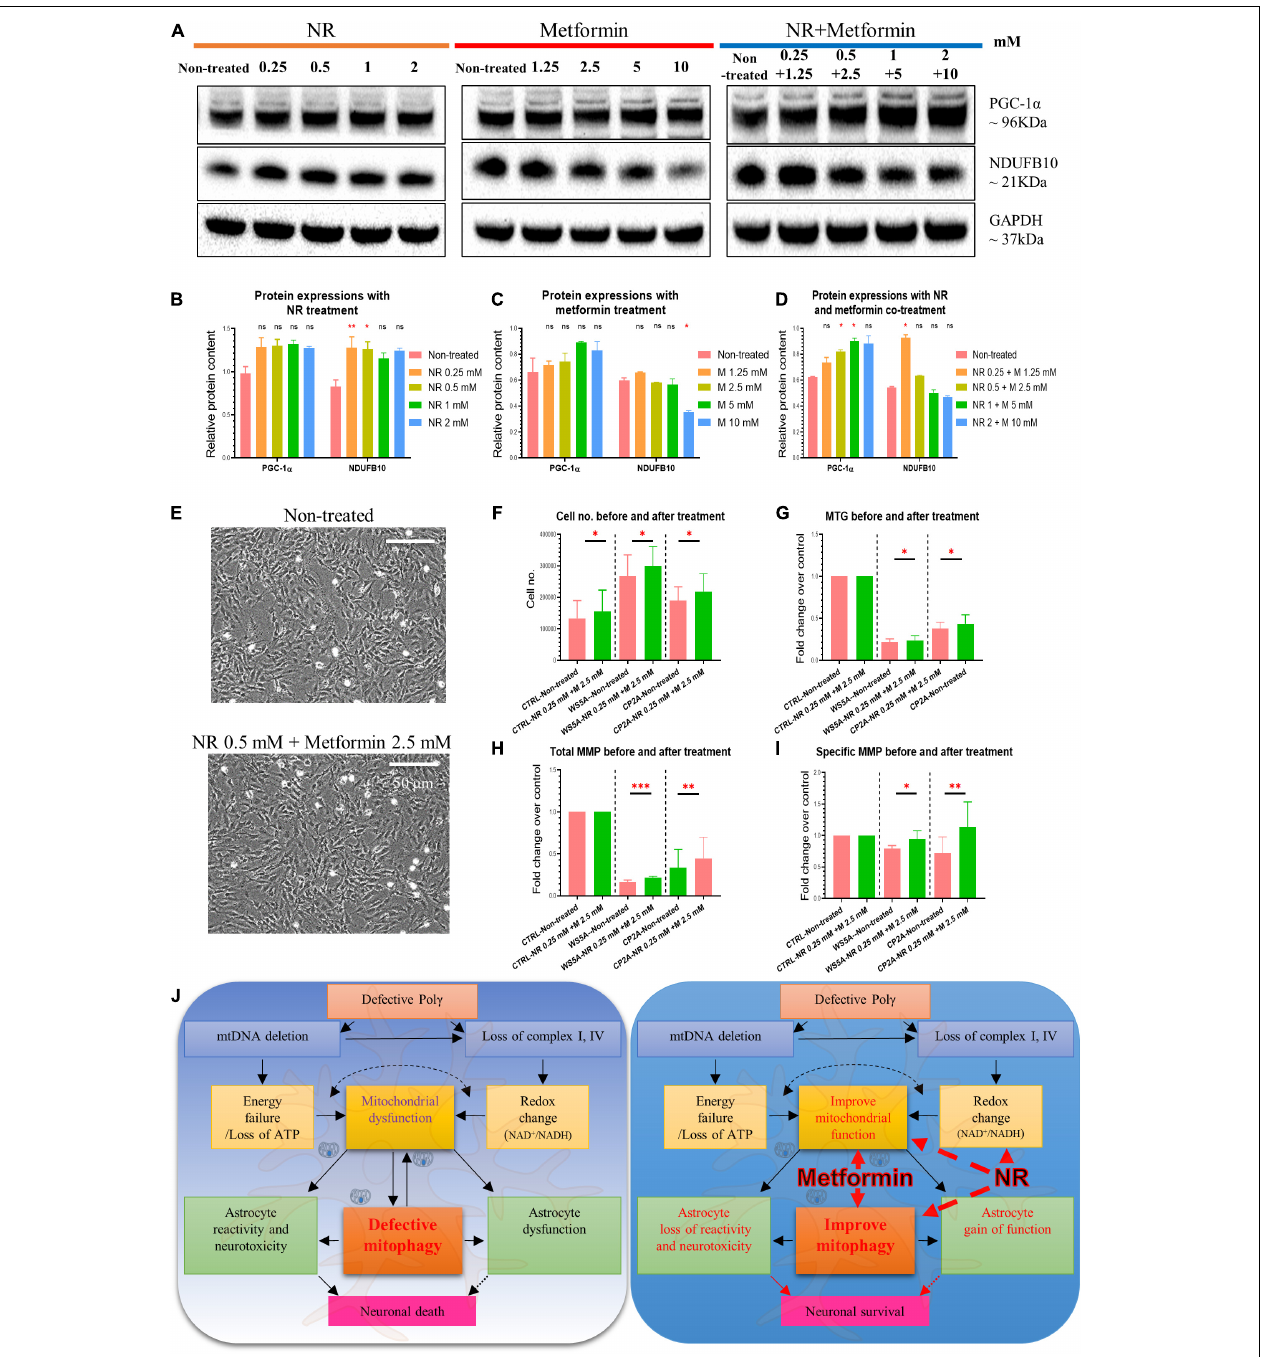
FIGURE 8 | Nicotinamide riboside and metformin treatment improve mitochondrial function in POLG-mutant astrocytes. (A) Representative images of the western blotting for NDUFB10, PGC-1 α , and GAPDH in the POLG WS5A astrocytes treated with a serial concentration of NR alone, metformin alone, and co-treatment for 72 h. (B–D) Protein quantifications of the western blotting in A for NDUFB10 and PGC-1 α in the POLG WS5A astrocytes treated with a serial concentration of NR alone (B) , metformin alone (C) , and co-treatment (D) for 72 h. (E) Representative phase-contrast images of WS5A astrocytes before and after the dual treatment of NR 0.5 mM and metformin 2.5 mM. Scale bar is 50 µ m. (F) Cell number counting of WS5A astrocytes before and after the dual treatment of NR 0.5 mM and metformin 2.5 mM. (G–I) Flow cytometric analysis for MTG (G) and MMP at total level measured by TMRE (H) and specific MMP level calculated by total TMRE/MTG (I) of WS5A astrocytes before and after the dual treatment of NR 0.5 mM and metformin 2.5 mM. MTG, MMP, and specific MMP were normalized with non-treated cells. (J) Summary of the possible disease mechanisms in astrocyte defects and neuronal loss in POLG-related disorders. Data information: the data in A–I